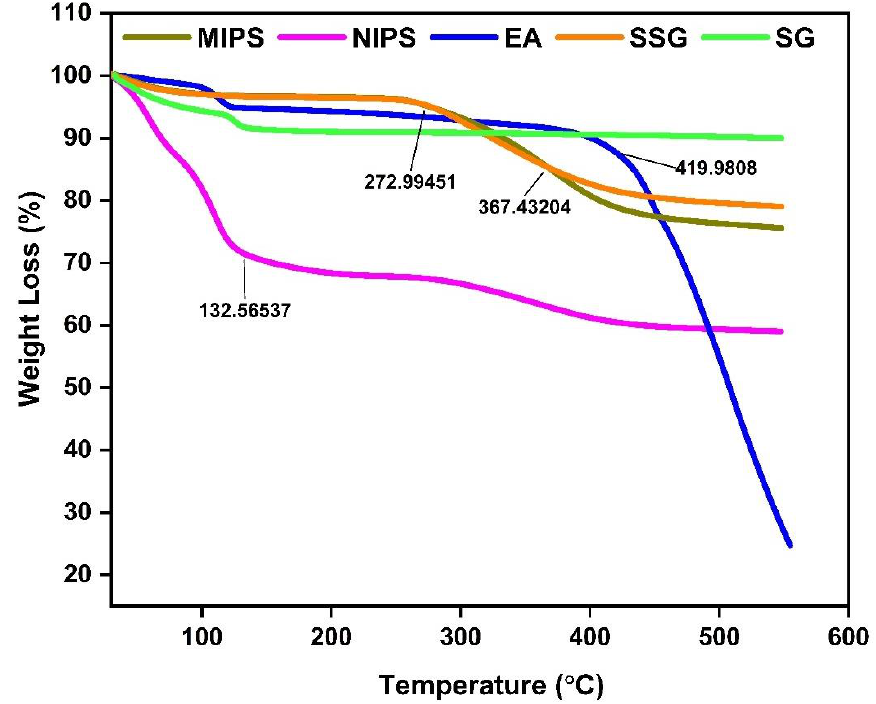
Figure 4. TGA curves of silica gel, silanized silica gel, MIPS, NIPS, and